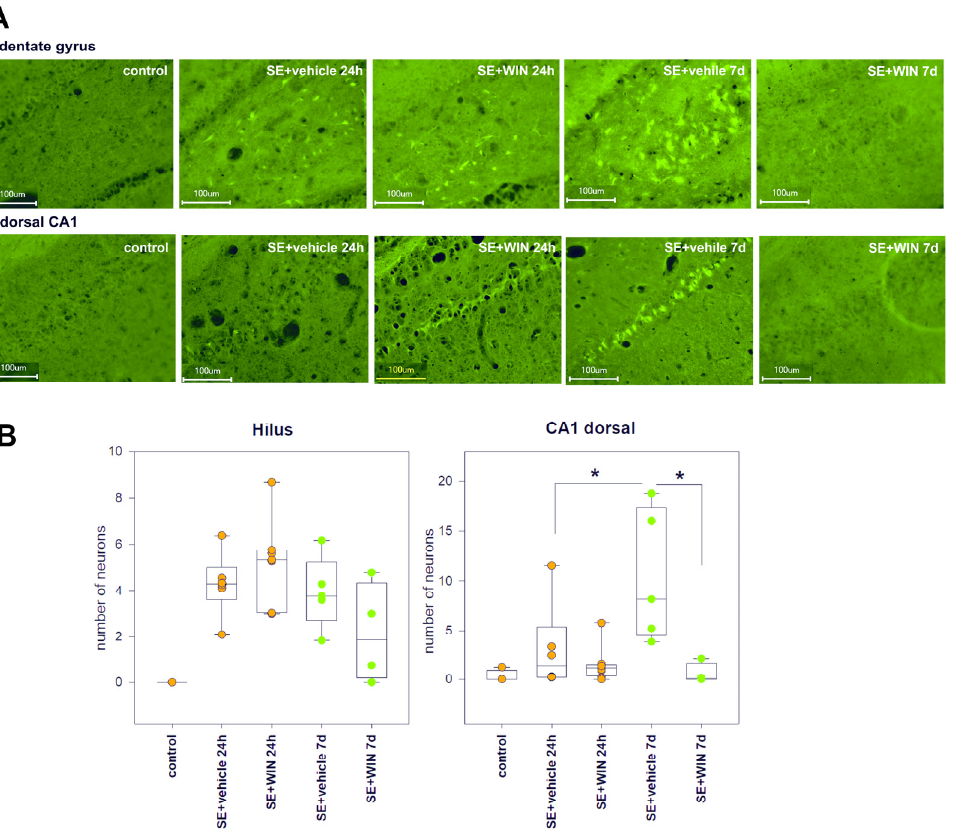
Figure 5. ( A ) Fluorojade C staining in the hilar region of the dentate gyrus (upper row) and dorsal CA1 (bottom row) in rats without SE (control), vehicle-treated treated rats (SE + vehicle), and WIN- 55,212-2-treated rats (SE + WIN) 24 h and 7 days after SE; ( B ) The number of fluorescent cells per field of view in the dentate gyrus and CA1 of the dorsal hippocampus in rats with no SE (control), vehicle-treated treated rats (SE + vehicle), and WIN-55,212-2-treated rats (SE + WIN) 24 h and 7 days after SE. Data are presented as medians with interquartile ranges; dots represent individual values for each rat. *—significant differences at p < 0.05, Kruskal–Wallis test, multiple comparisons post hoc.